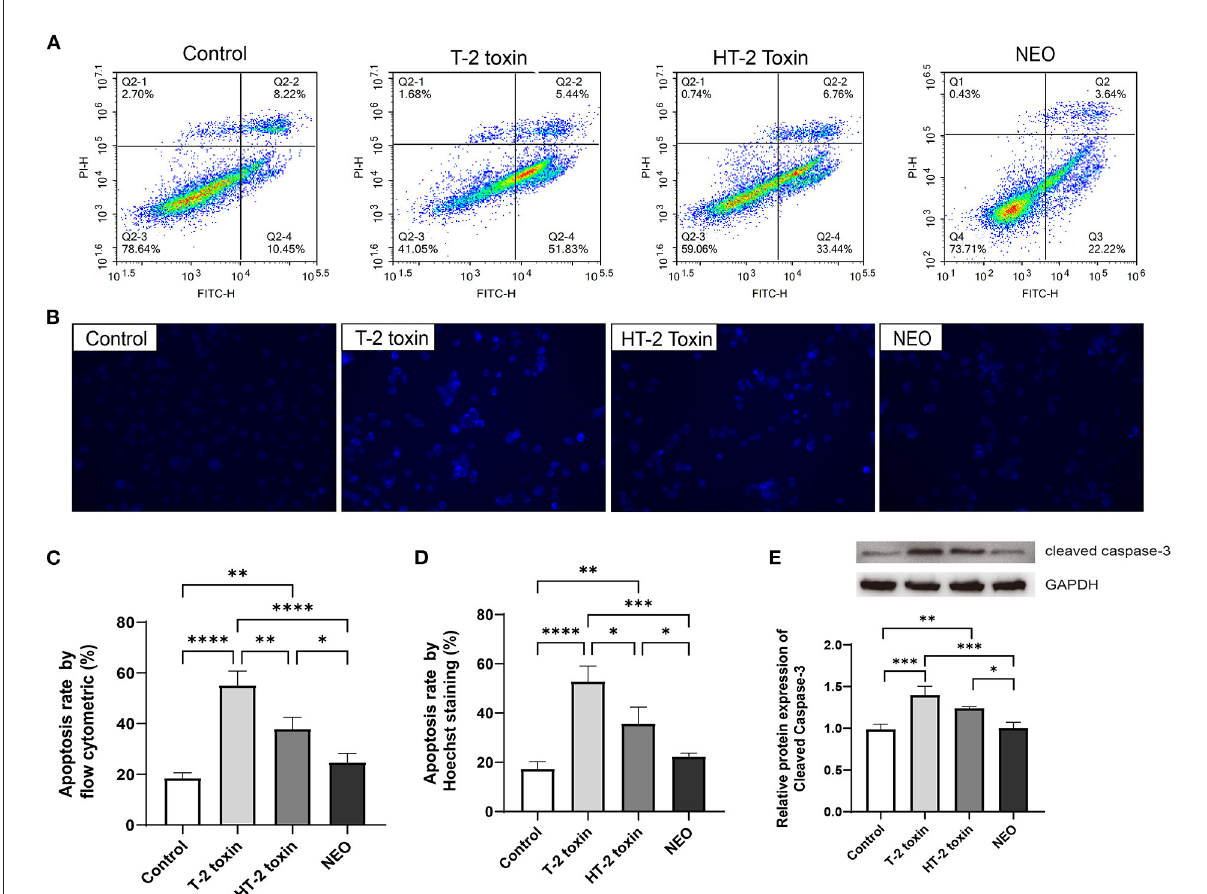
FIGURE5 Increased cell apoptosis after treated with T-2 toxin and its hydrolytic metabolites. Apoptosis of chondrocytes was determined by flow cytometry analysis (A) and Hoechst 33258 staining (B) , the strong fluorescence in the cell nucleus was considered to be apoptosis cells ( × 400); Apoptosis rates for flow cytometry (C) and Hoechst 33258 staining (D) ; (E) Relative protein expression of Cleaved Caspase-3. C28/I2 cells were treated with 20ng/mL of T-2 toxin, HT-2 toxin and NEO, or the same volume of PBS for 24h. Data are presented as mean ± SD ( n = 6 each). * P < 0.05, ** P < 0.01, *** P < 0.001, **** P < 0.0001. NEO,